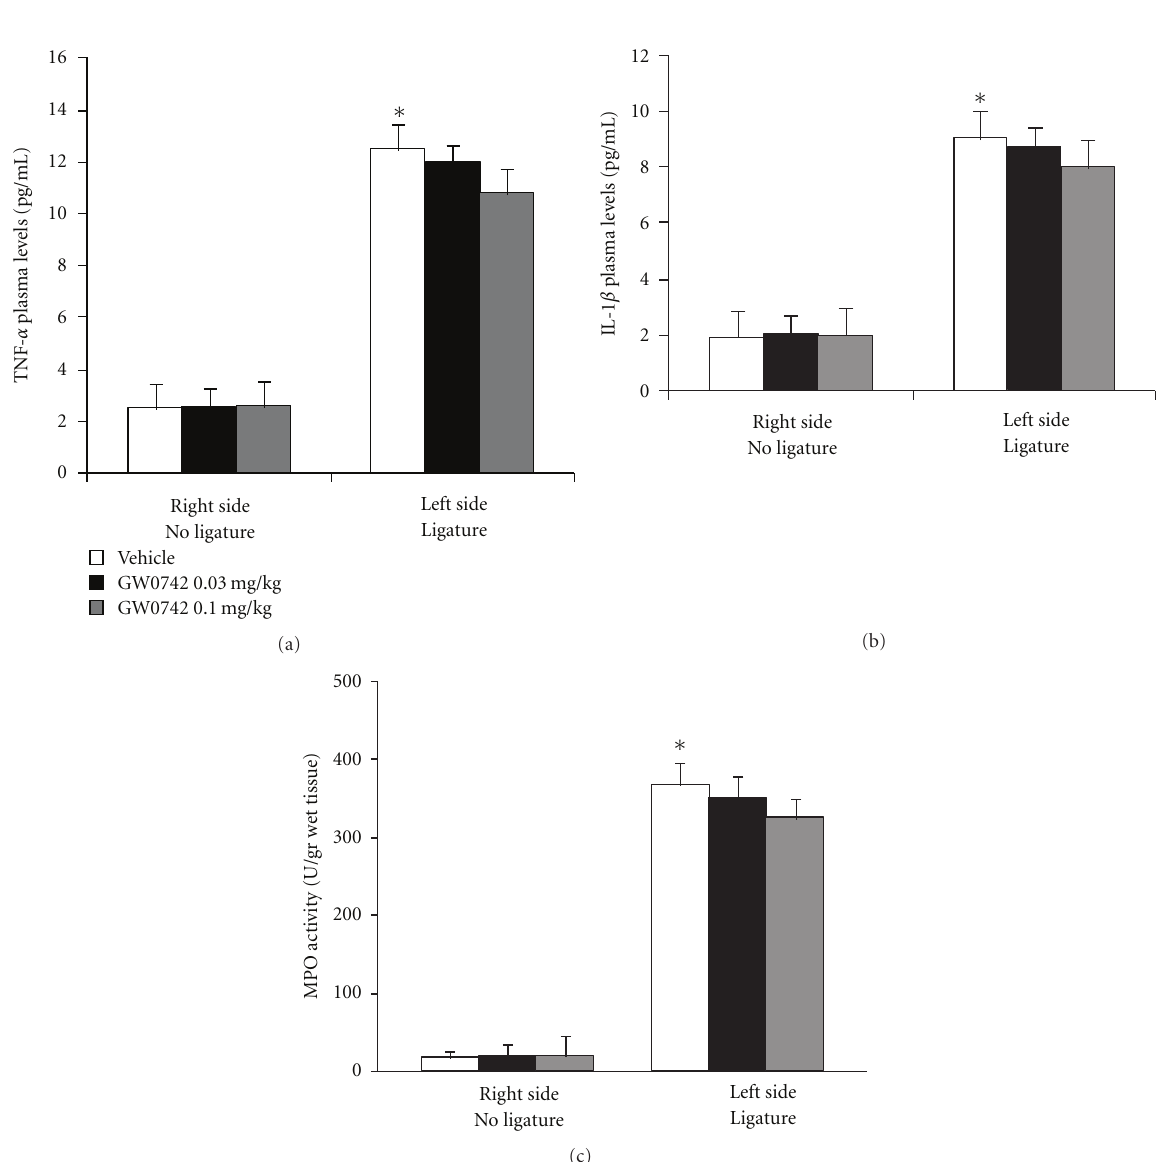
Figure 6: E ff ects of GW0742 dose response on inflammatory parameters. A substantial increase in TNF- α , IL-1 β formation and MPO activity was observed in gingivomucosal tissues at eight days following ligation, when compared with the gingivomucosal tissues from the contralateral side (Figures 6(a), 6(b), and 6(c), resp.). Administration of GW0742 at di ff erent doses (0,03 and 0,1 mg/kg) did not reduce TNF- α , IL-1 β formation and MPO activity in gingivomucosal tissues at eight days following ligation (Figures 6(a), 6(b), and 6(c),